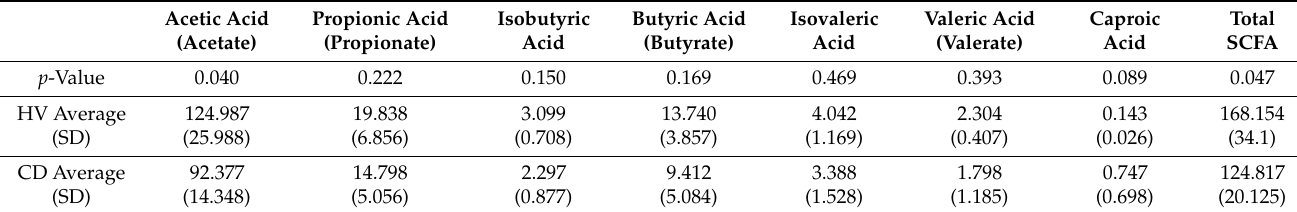
Table 2. Individual SCFA concentrations ( µ mol/g of feces) and total SCFA values in fecal samples from celiac disease (CD) patients and healthy volunteers (HV).